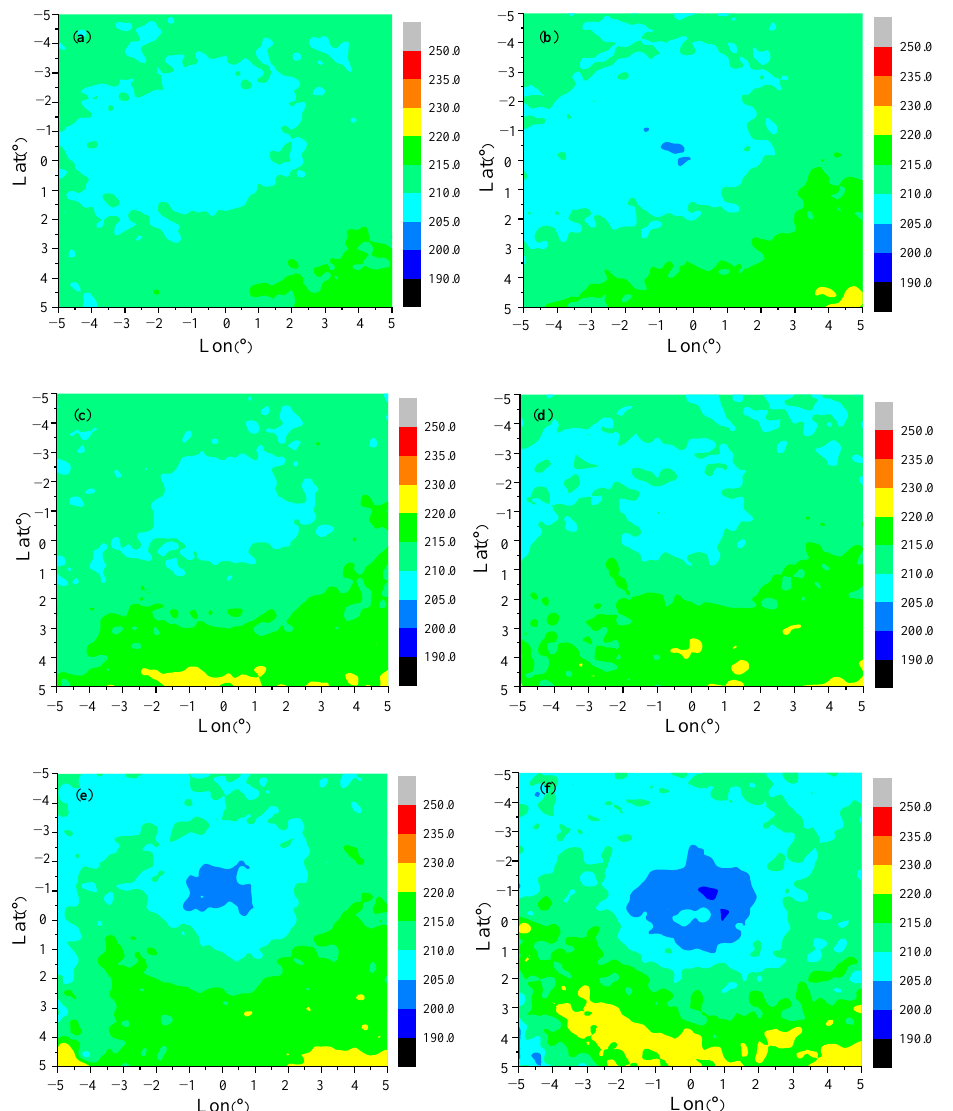
Figure 8. Statistics of ice cloud top pressure by different TC intensity.